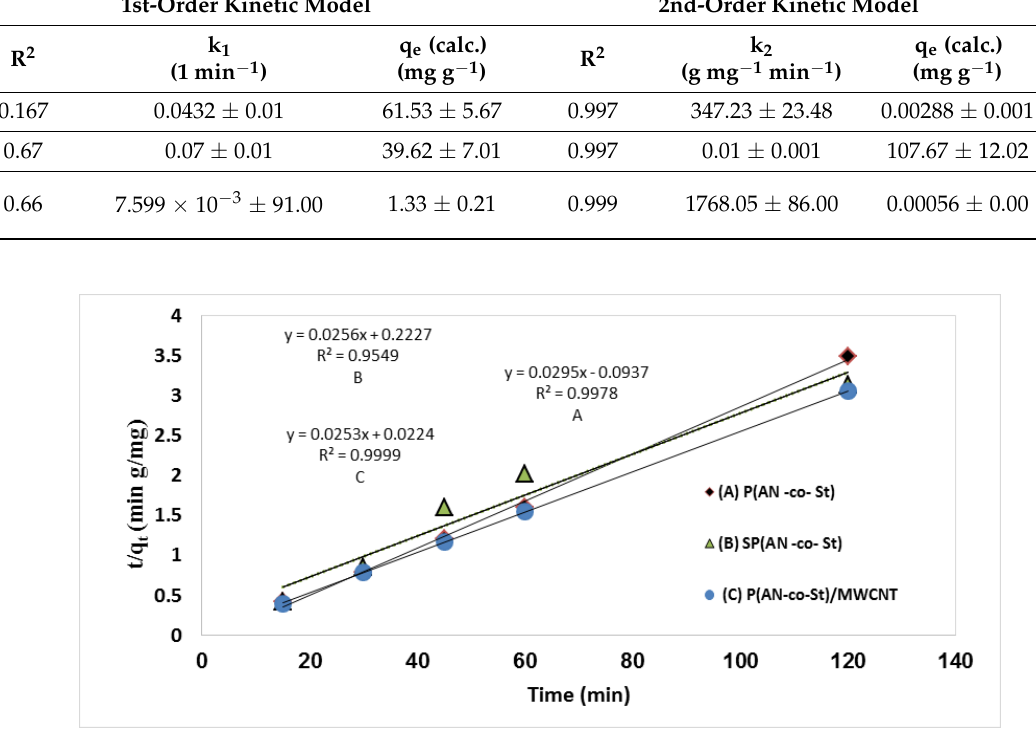
Figure 14. First-order kinetics for the removal of MO onto various composites. Table 6. Parameters for adsorption kinetics.